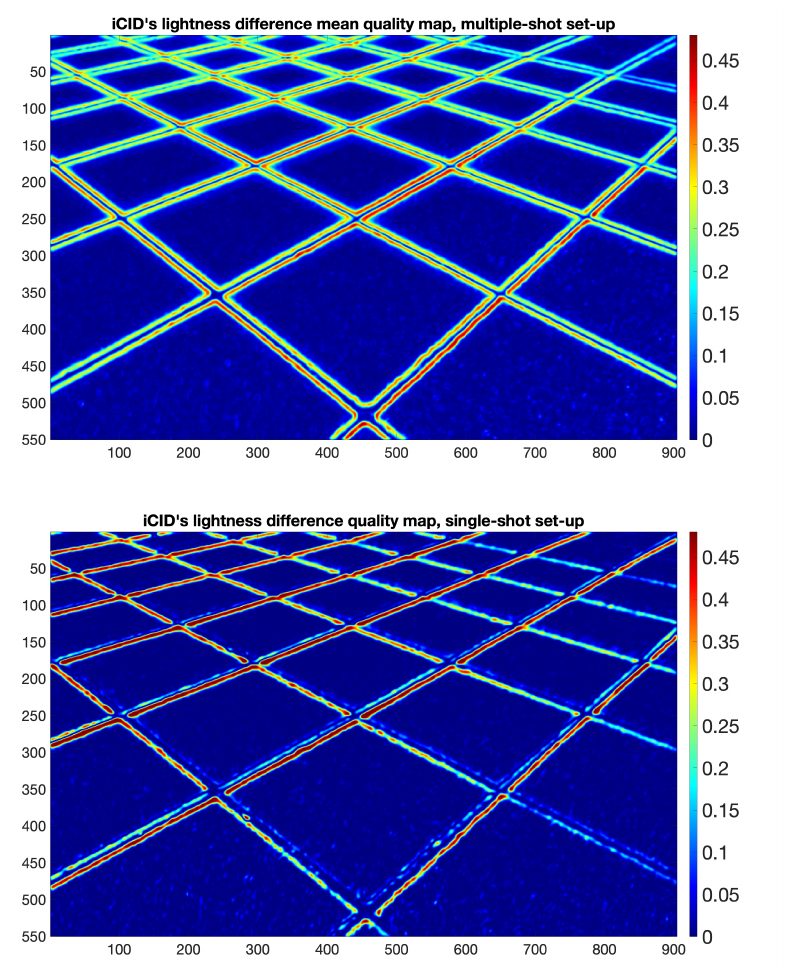
Figure 4. iCID’s lightness difference (mean) quality maps for the tiles image with unnatural elevation print used as test image and surface roughness print used as reference image from the MS ( top ) and the SS ( bottom ) captures. It shows that iCID’s lightness difference map is the most responsive (i.e., detects larger differences) on the edges in both set-up captures and that the responsiveness is better captured in the MS captures compared to the SS ones. Zero means there is no